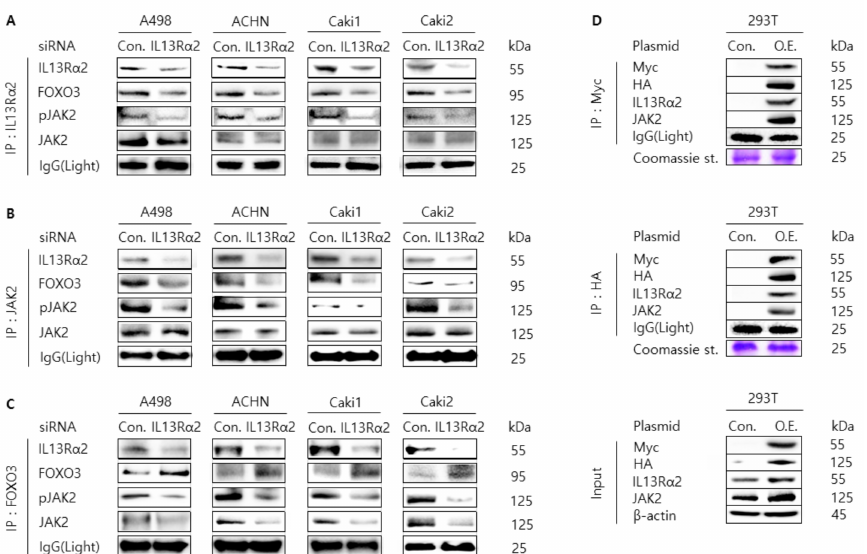
Figure 4. Protein interaction between IL13R α 2 and JAK2. Knock-down of IL4R α 2 in A498, ACHN, Caki1, and Caki2 cells reduced the interaction between IL13R α 2 and JAK2. Cells were transfected with siRNA against IL4R α 2 or control siRNA. Then cell lysates were immunoprecipitated with antibodies against IL4R α 2 ( A ), JAK2 ( B ), or FOXO3 ( C ). The immunoprecipitated proteins were immunoblotted by IL4R α 2, pJAK2, JAK2, and FOXO3 antibodies. Light chain of IgG was used for the loading control. ( D ) 293T cells were co-transfected with Myc-IL4R α 2 and HA-JAK2 (O.E.) or a control plasmid DNA (pCMV6-C-Myc-Flag and pCMV3-C-HA, Con.) as indicated. Then cell lysates were immunoprecipitated with antibodies against Myc or HA. The immunoprecipitated proteins were immunoblotted by Myc, HA, IL4R α 2, JAK2 antibodies. Light chain of IgG and Coomassie Blue staining of SDS–PAGE were used for the loading